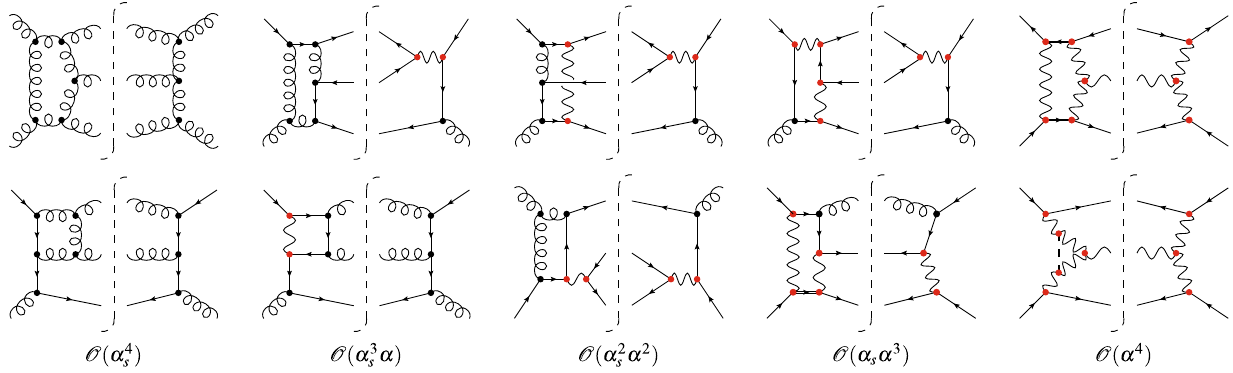
Fig. 2 Representative leading and subleading virtual correction dia- grams for pp → 3 j production. The occurrence of interferences, QCD and EW loops, gauge boson (wavy line), Higgs boson (dashed line) and